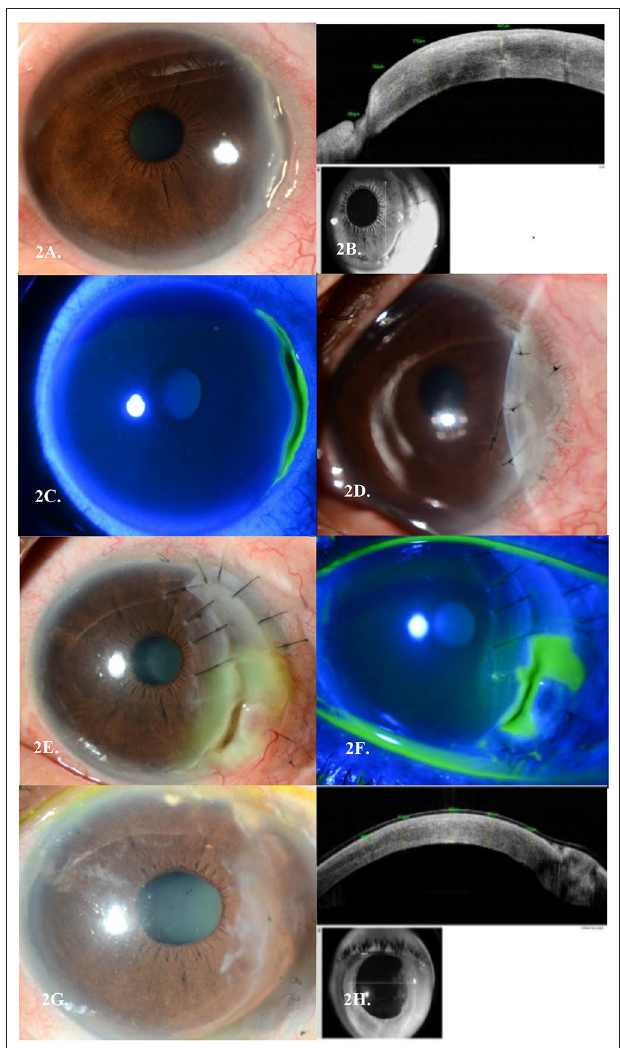
FIGURE 2 | (A) Peripheral ulcerative keratitis (PUK) seen in Case 2’s left eye temporally. (B) Corresponding AS-OCT cuts through the areas of thinning in each eye, respectively. (C) Corresponding staining of areas of cornea melt temporally. (D) Left Amniotic Membrane Transplant (AMT) in view of